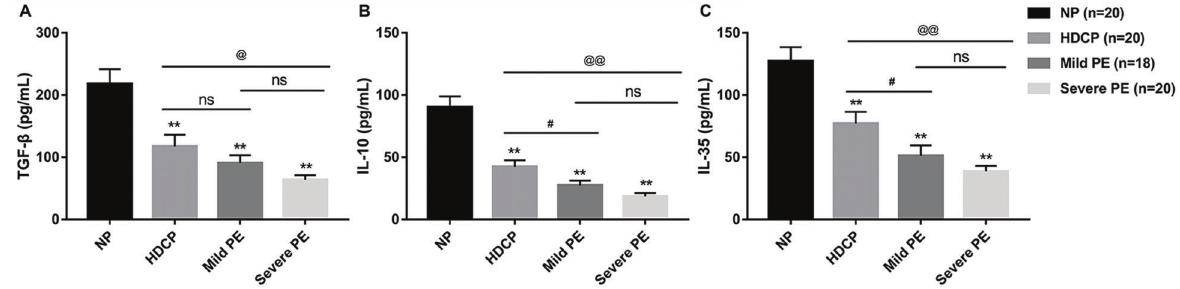
Figure 1. The serum levels of A , TGF- b , B , IL-10, and C , IL-35 in normal pregnancy (NP), hypertensive disorder complicating pregnancy (HDCP), mild preeclampsia (PE), and severe PE were measured with commercial ELISA kits. Data are reported as means ± SD. **P o 0.01 vs NP; # P o 0.05 mild PE vs HDCP; @ P o 0.05, @@ P o 0.01 severe PE vs HDCP; ns: not signi fi cant ( t